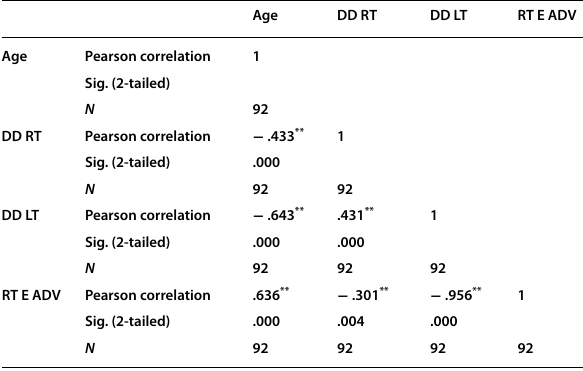
Table 8 Pearson correlation between age and DD